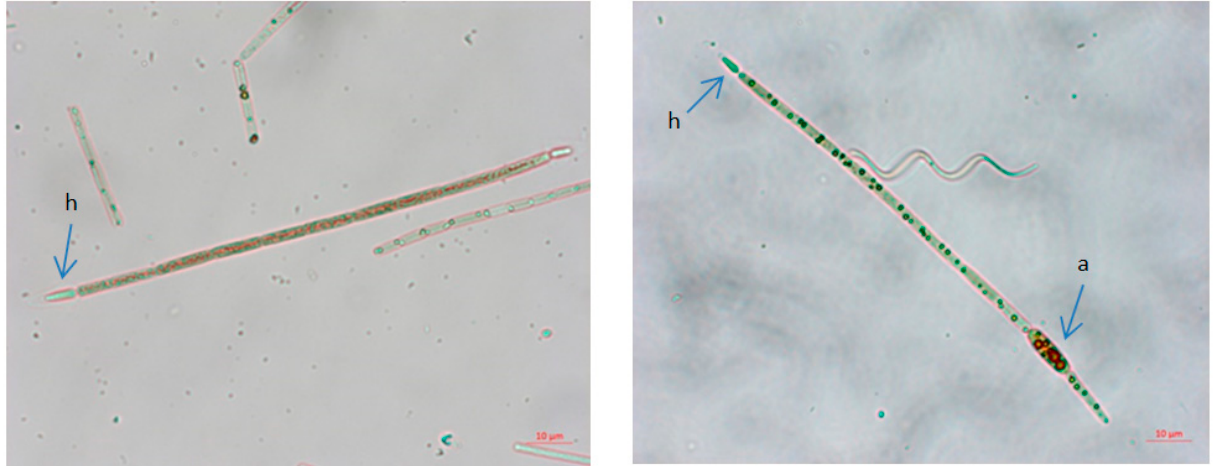
Figure 10. Photomicrographs of Raphidiopsis raciborskii from Aleksandrovac Lake. Scale bars 10 μ m. Legends: a—akinetes, h—heterocyst.